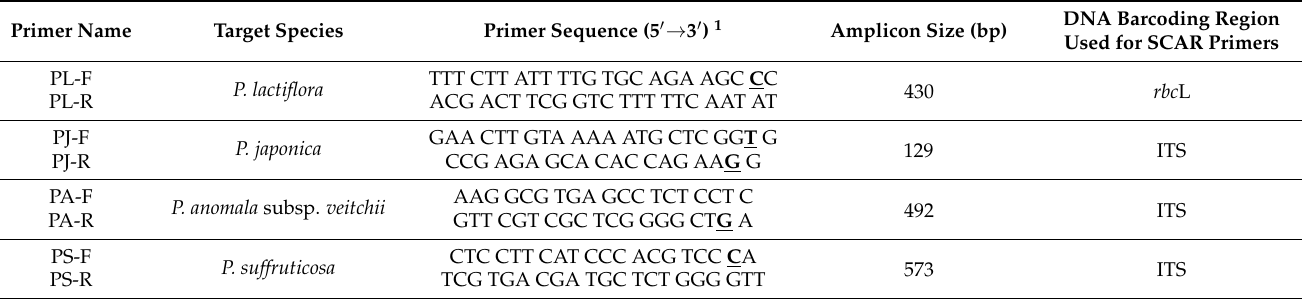
Table 1. Details of primers used to perform the conventional PCR assay.